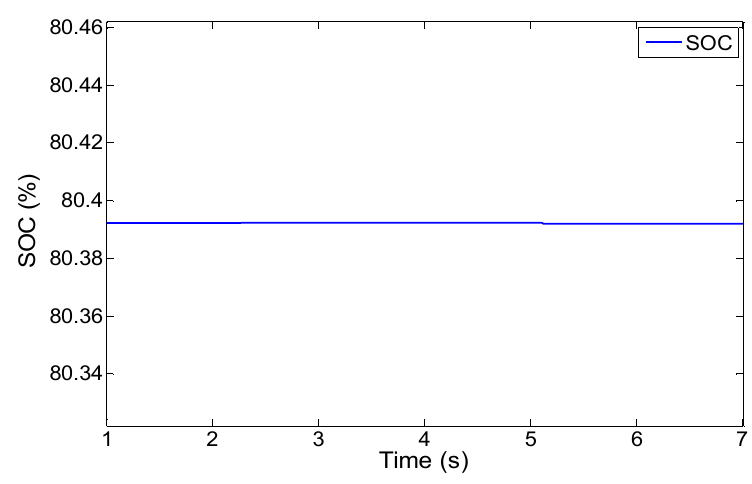
Figure 25. SOC level was constant in its maximum level under idle mode.